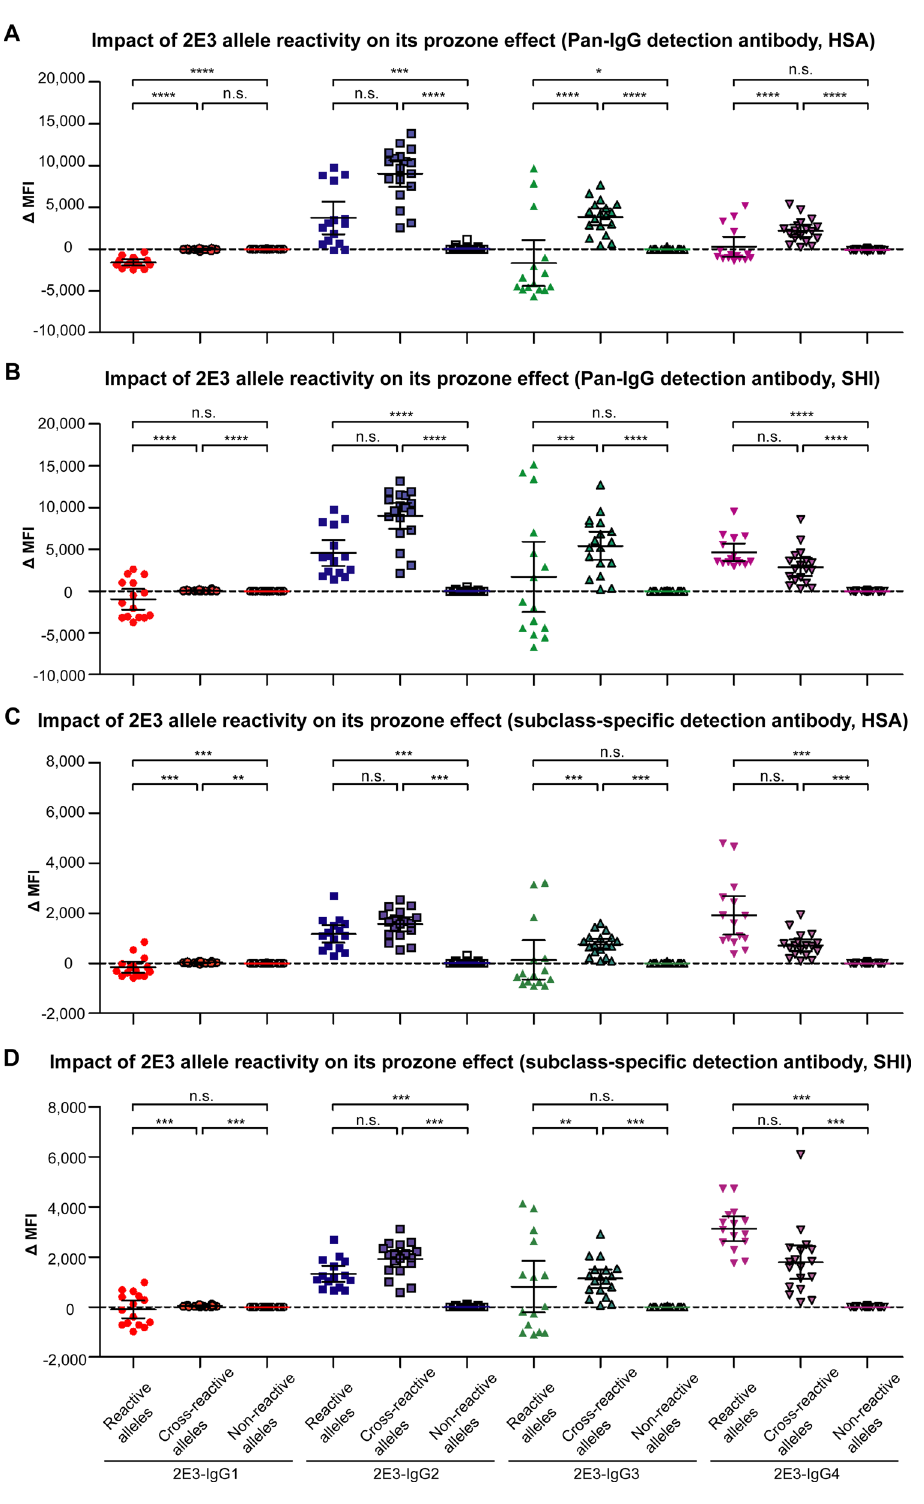
Figure 3. Impact of 2E3 binding reactivity on prozone effect observed in the SAB assay. The MFI difference (∆MFI) between 2E3 tested at 2 μg/mL and 2E3 tested at 10 μg/mL was calculated for each allele and plotted according to the 2E3 reactivity categories as classified in Table 1 and different 2E3 subclasses using ( A , B ) Pan-IgG detection reagent, and ( C , D ) corresponding subclass-specific detection reagents . Data represented as mean with 95% CI. Statistical significance between reactive (N = 15), cross-reactive (N = 18) and non-reactive categories of the same subclass (N = 64) tested at the same center was calculated by one-way ANOVA Kruskal– Wallis tests followed by Dunn’s multiple comparisons test. Figure illustrates results from both laboratories. SAB single antigen beads, MFI mean fluorescence intensity, HLA human leukocyte antigen, CI confidence interval, ANOVA analysis of